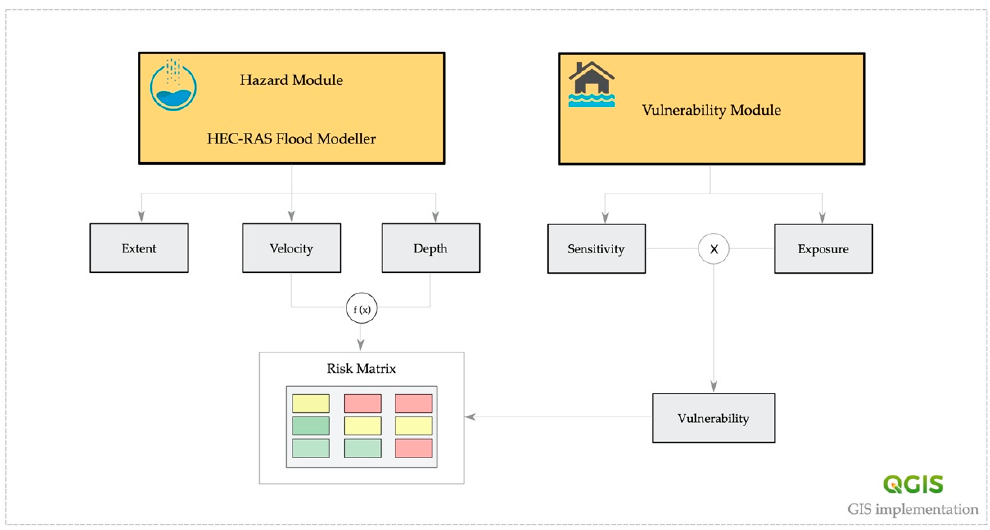
Figure 2. The conceptual framework of the integrated flood risk assessment approach.